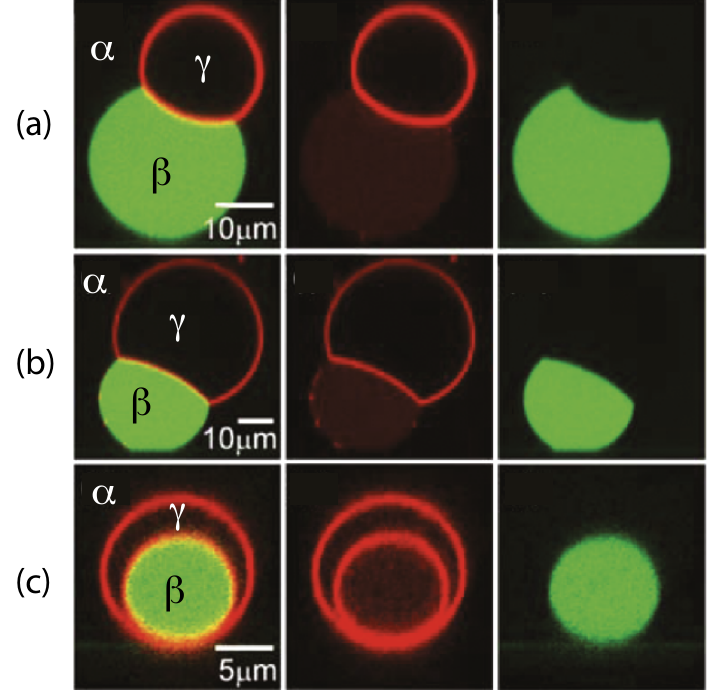
Figure 3. Adhesion morphologies of giant unilamellar vesicles (GUVs) exposed to exterior PEG- dextran solutions that undergo liquid–liquid phase separation into the PEG-rich bulk phase α (black) and the dextran-rich condensate droplet β (green): ( a ) Partial wetting of vesicle membrane by condensate droplet; ( b ) Partial wetting of the membrane by the droplet and partial engulfment of the droplet by the membrane; and ( c ) Complete engulfment of the droplet by the membrane which forms two spherical segments (red) connected by a narrow membrane neck, which is too small to be resolved. The middle column displays the red membrane channel, the right column the green droplet channel. The superimposed red and green channels are shown in the left column. In ( a , b ), the vesicle membrane exhibits an apparent membrane kink that reflects the limited spatial resolution of the optical microscope [11]. (With permission from